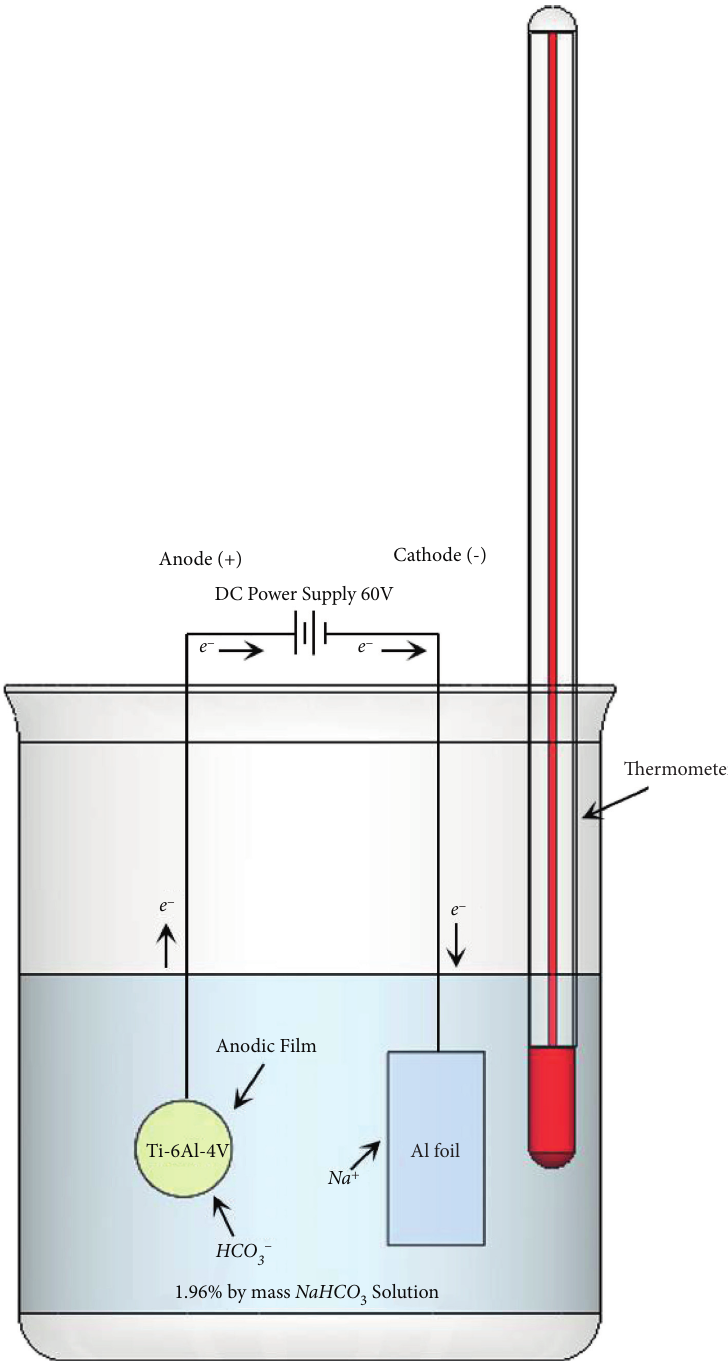
Figure 1: Schematic diagram of the anodizing process of